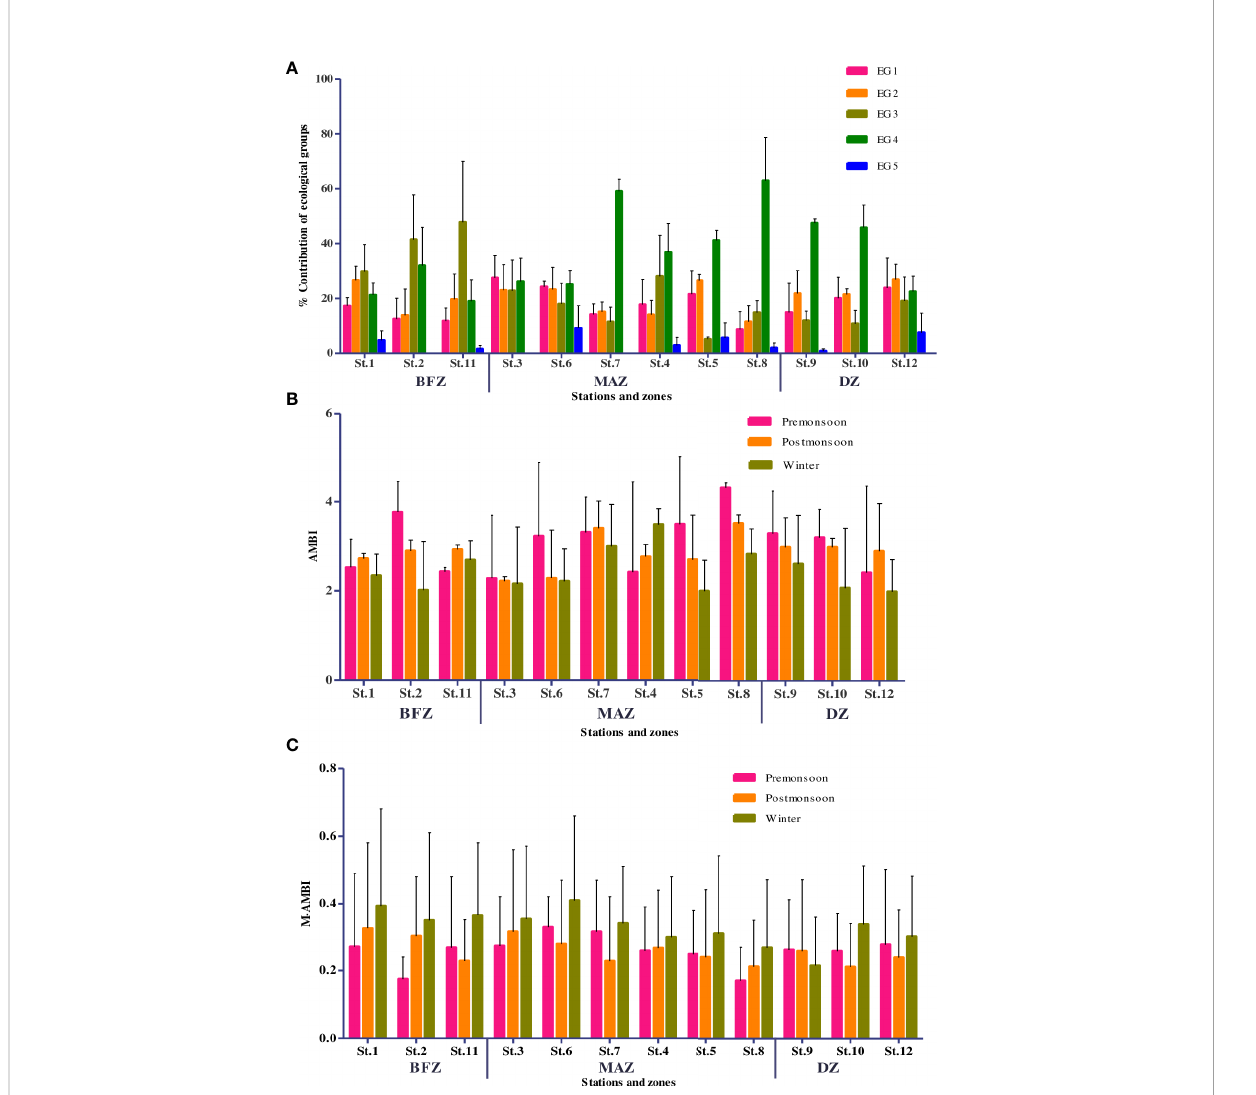
FIGURE 6 (A) Ecological groups associated with stations/zones of Mahanadi estuary; (B) AMBI and (C) M-AMBI seasonal variations across stations/zones in Mahanadi